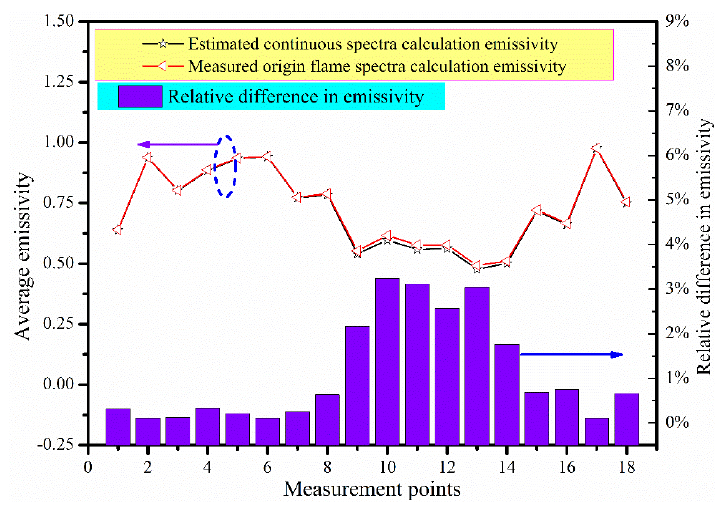
Figure 12. Influence of radiation intensity of discontinuous emission spectra on the calculation of average emissivity.